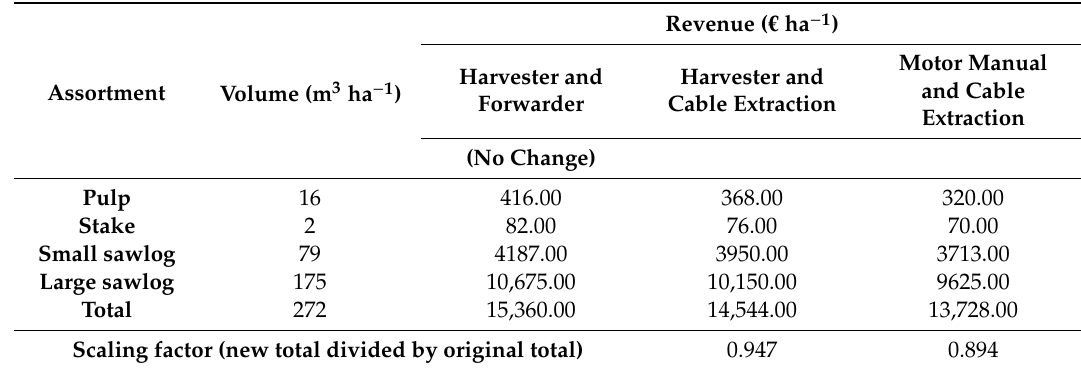
Table 8. Example of the calculation of the scaling factors for each harvest type using the clearfell volume of Sitka spruce with a yield class 14 at age